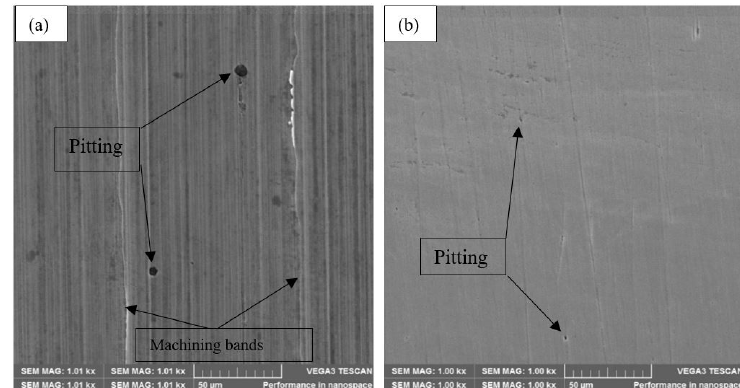
Figure 16. Samples of tests 1 (a) and 1P (b) with 1000X